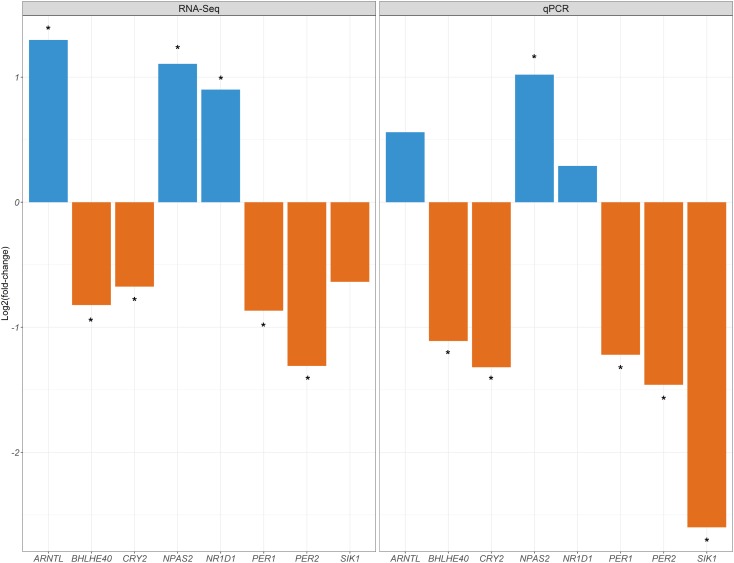
Comparison of the log2FC values generated in the current experiment for the muscle tissue (T0 vs. T2) with the log2FC values reported by Cardoso et al. (2017) for the same muscle samples (T0 and T2) and genes based on RNA-Seq data. Upregulation and downregulation of mRNA expression are indicated with blue and orange bars, respectively. Asterisks indicate the existence of significant differences in mRNA expression (q-value < 0.05 and | log2FC| > 0.58).